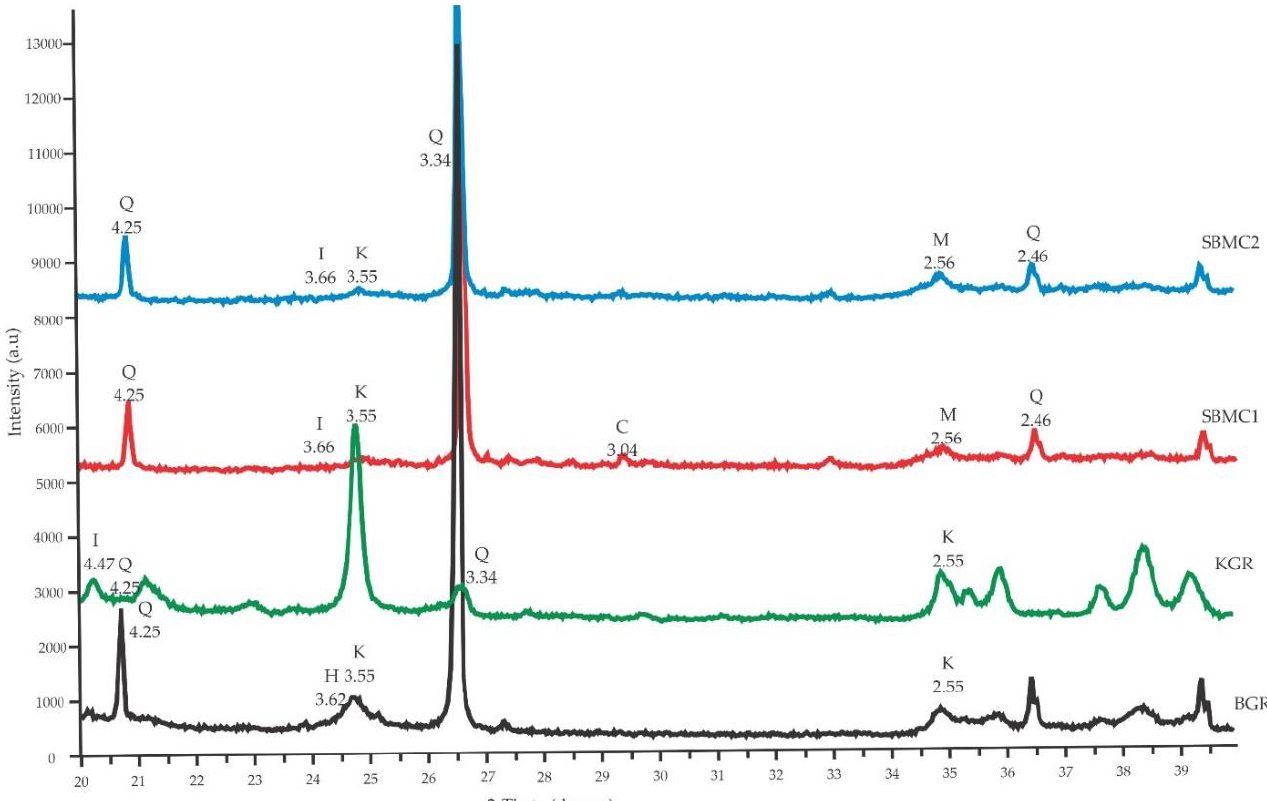
Figure 2. XRD pattern of freshly granitic residual soils and marine clays.